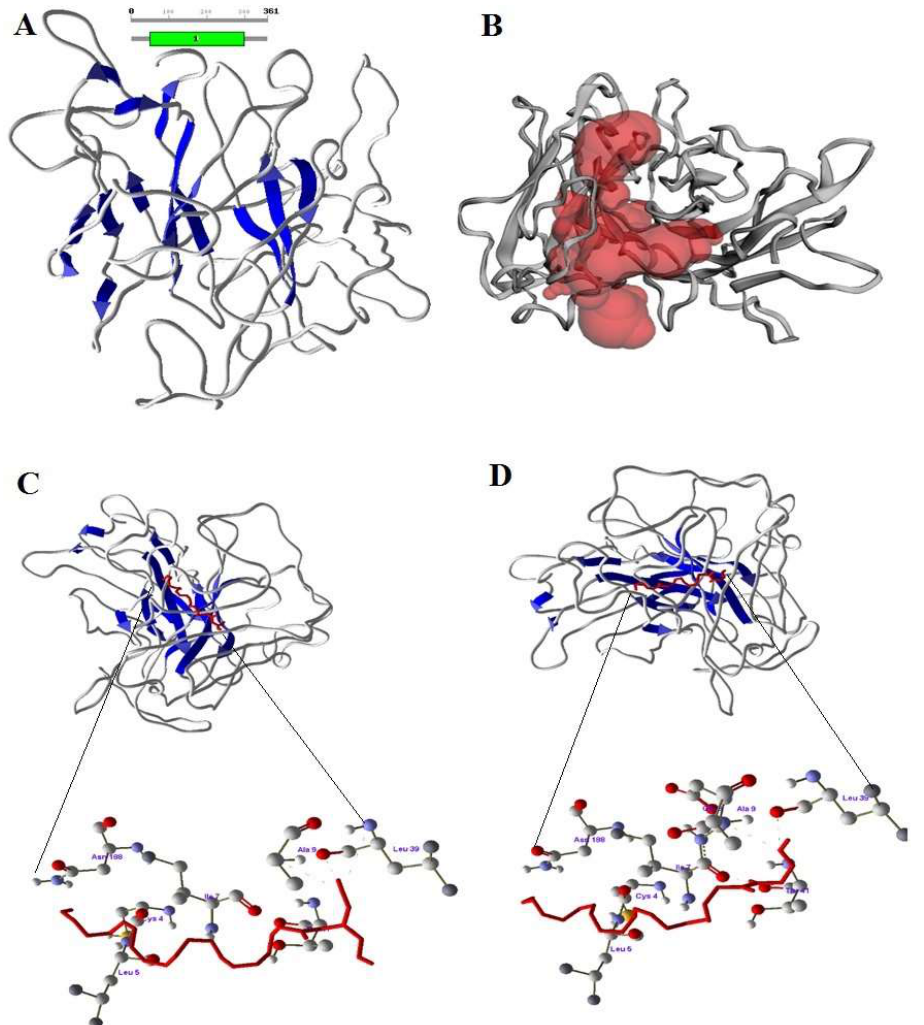
Figure 4. ( A ) Structure of CB2 with sheets (blue color) ( B ) Active site of CB2 in red color pocket in the structure ( C ) Docking of 2-AG (red color) and Amino acids of CB2 involved in docking with 2-AG. ( D ) Docking of AEA (red color) with CB2 and Amino acids of CB2 involved in docking with AEA.